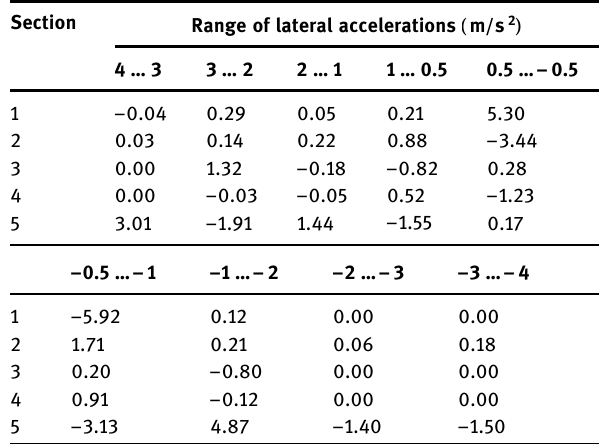
Table 6: Percentage di ff erences in the frequency of occurrence